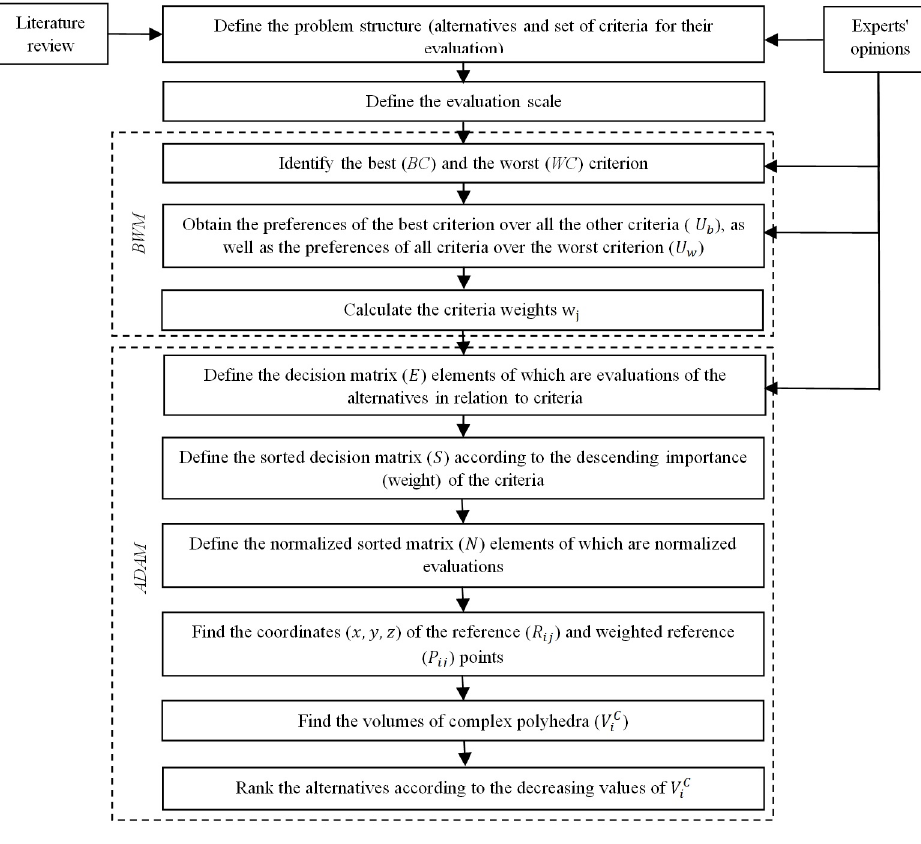
Figure 1. The general concept of the MCDM model.